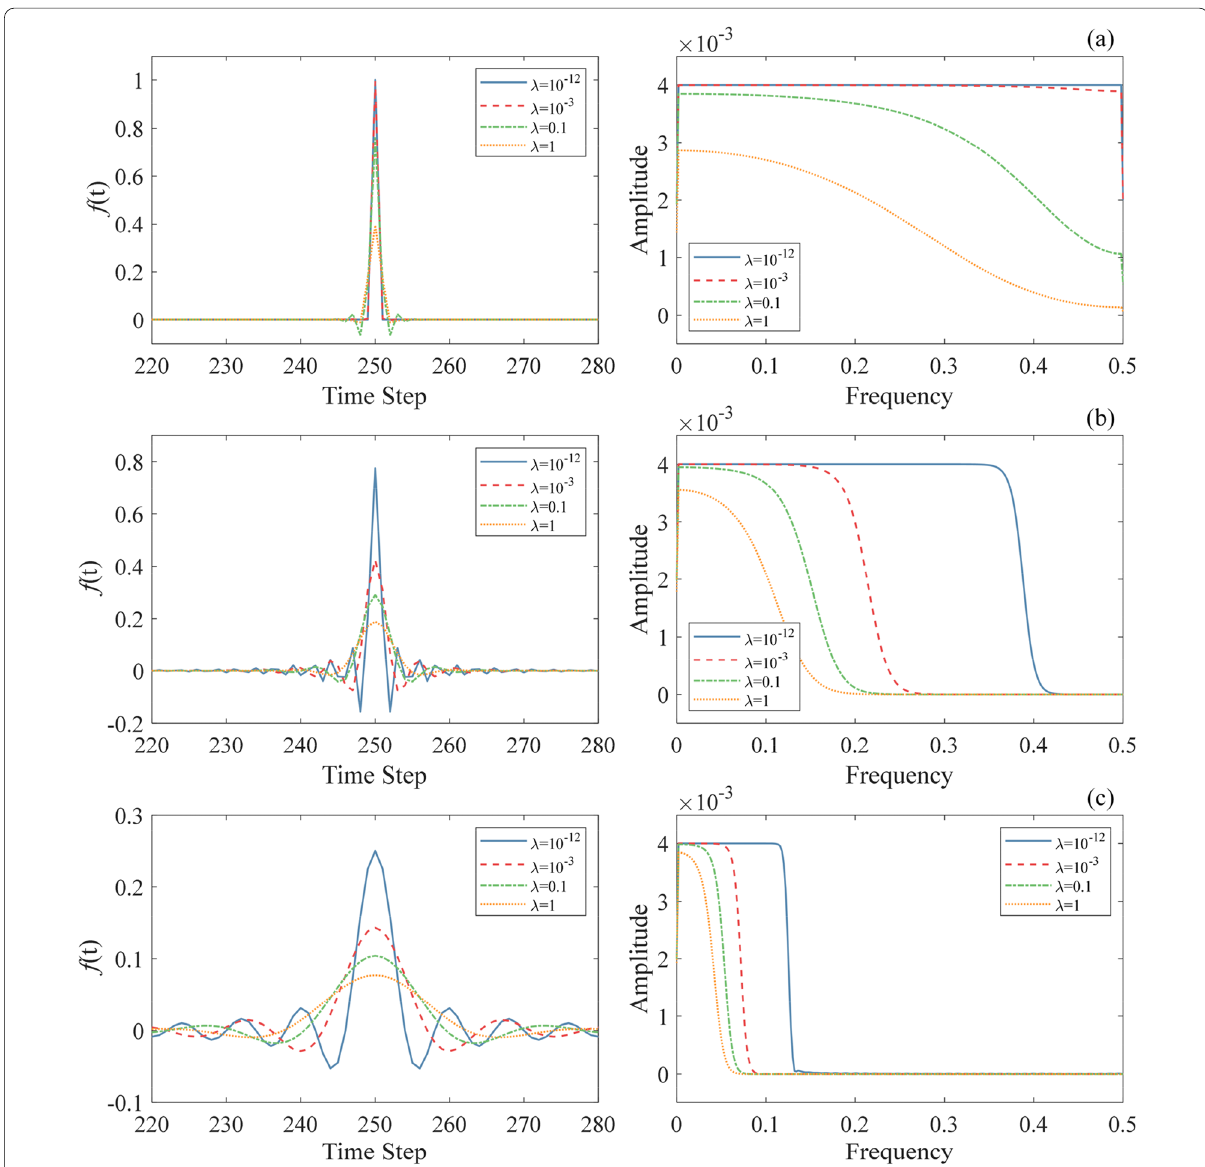
Figure 1 Influences of σ and (cid:31) on f when the system is excited by an impulse signal: a σ 2 = 1 , b σ 2 = 10 , and c σ 2 =